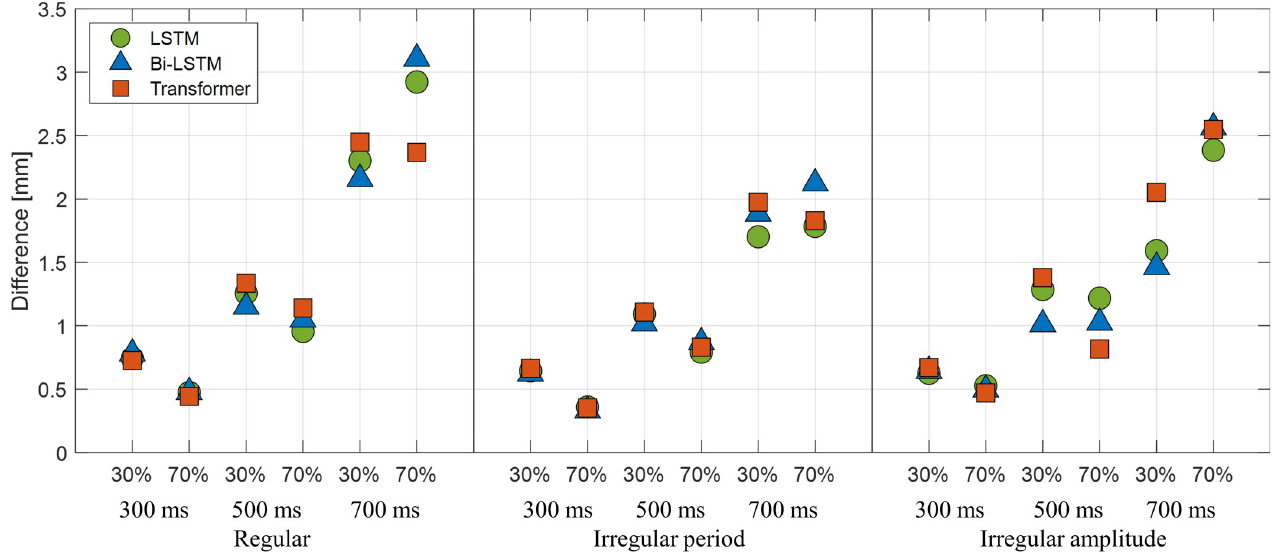
Fig 6. Average error results in millimeters. At 30% and 70% phases for regular and irregular patterns with three different prediction points: 300, 500, and 700 ms.